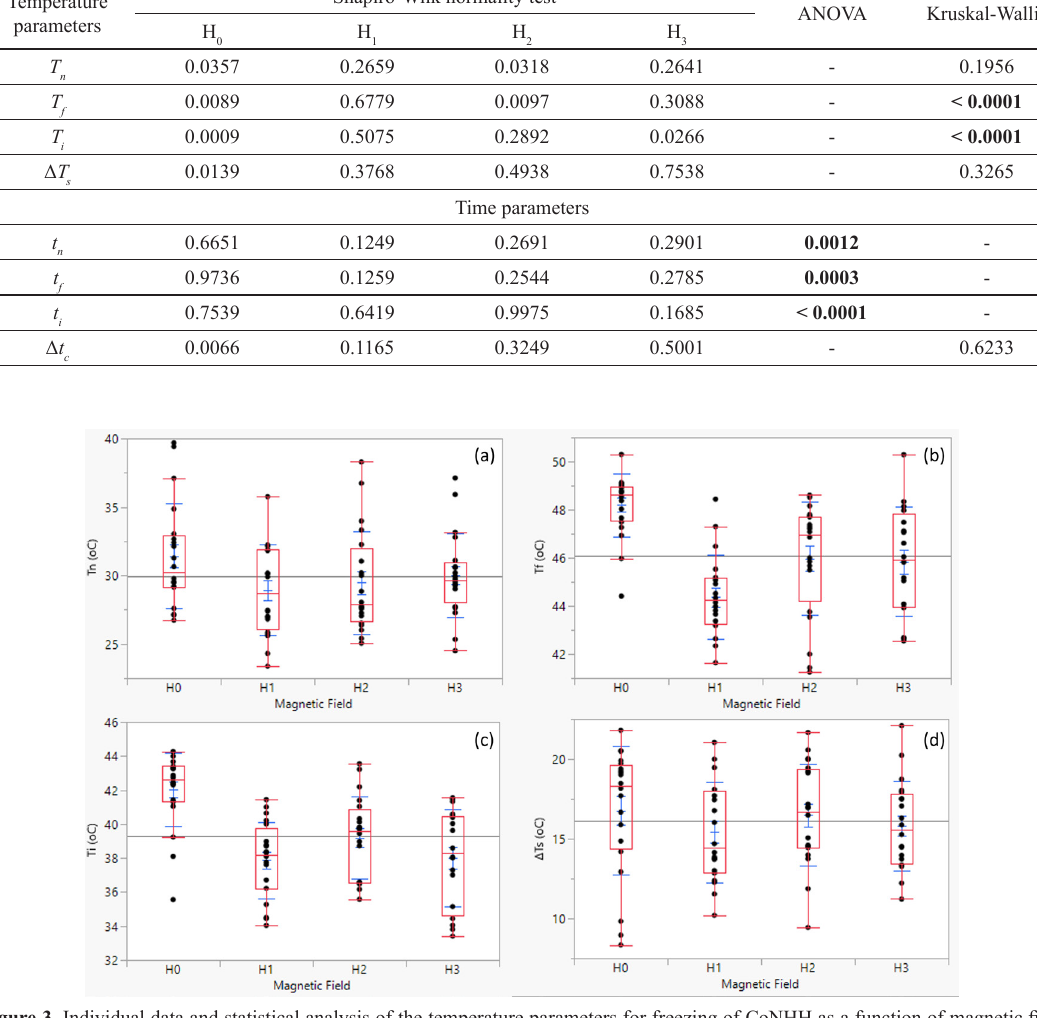
), (b) freezing temperature ( T ), (c) inflection temperature ( T ), and (d) supercooling degree (Δ T n f i